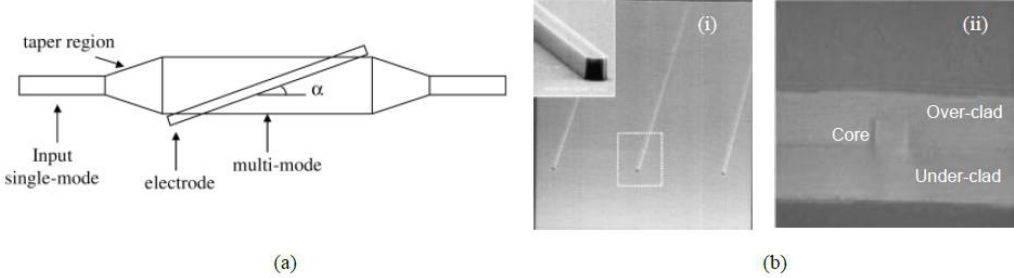
Figure 22. ( a ) Schematic of polymer waveguide TO VOA and ( b ) characterization of UV-imprinted single mode waveguide [74]. Copyright 2006 Elsevier.